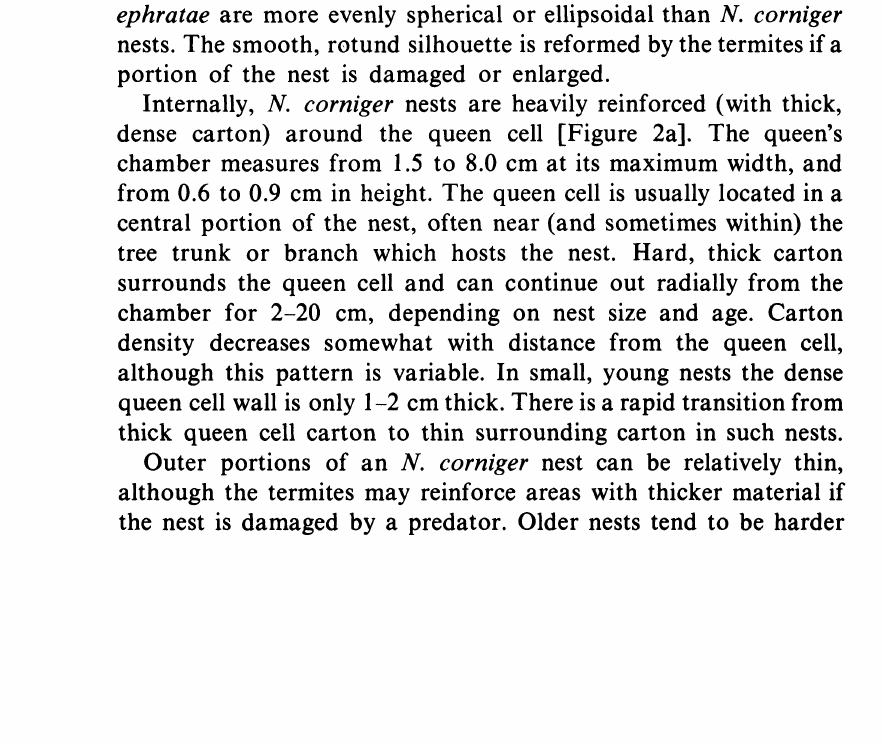
Figure 1. A.N. corniger nest; B. N. ephratae nest. Note the differences in surface texture and